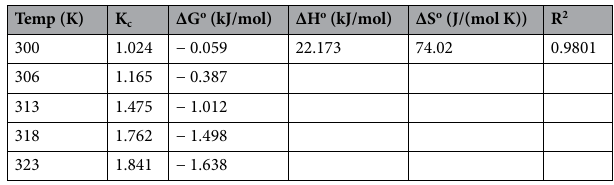
Table 4. Thermodynamic parameters for bromophenol blue adsorption onto ZnONPs.